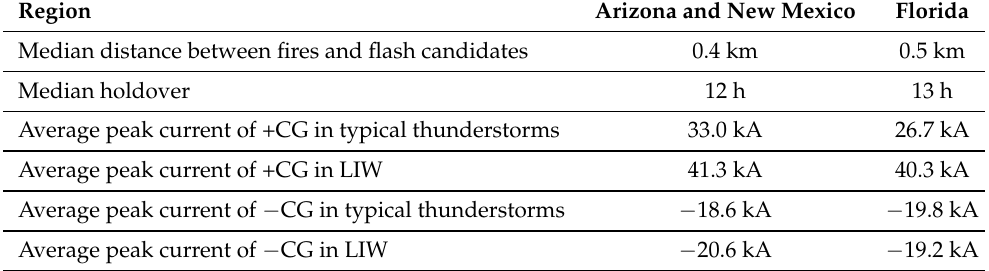
Table 2. Cont. Region Median distance between fires and flash